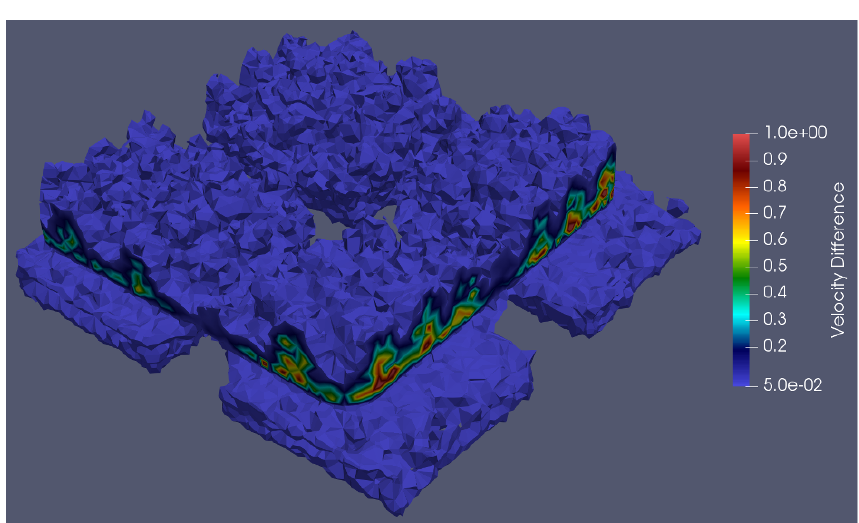
Figure 19. Difference in velocity magnitude between filtration flow through an poroelastic hydrogel, modeled by the Biot model, and rigid hydrogel, modeled by Darcy law. Red is high and blue is low velocity difference. Biot filtration velocity has a higher magnitude, indicating that hydrogel elasticity is conducive to increased filtration flow.